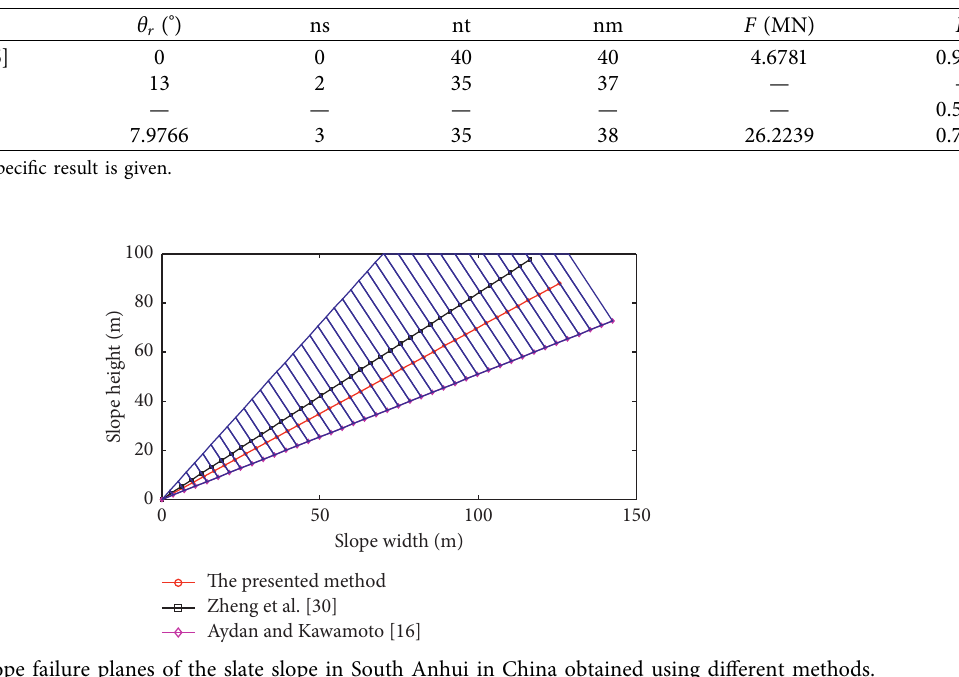
Figure 5: Schematic diagram of a slate slope in South Anhui in China [31]. Table 2: Result comparisons of the slate slope in South Anhui in China obtained using different methods.